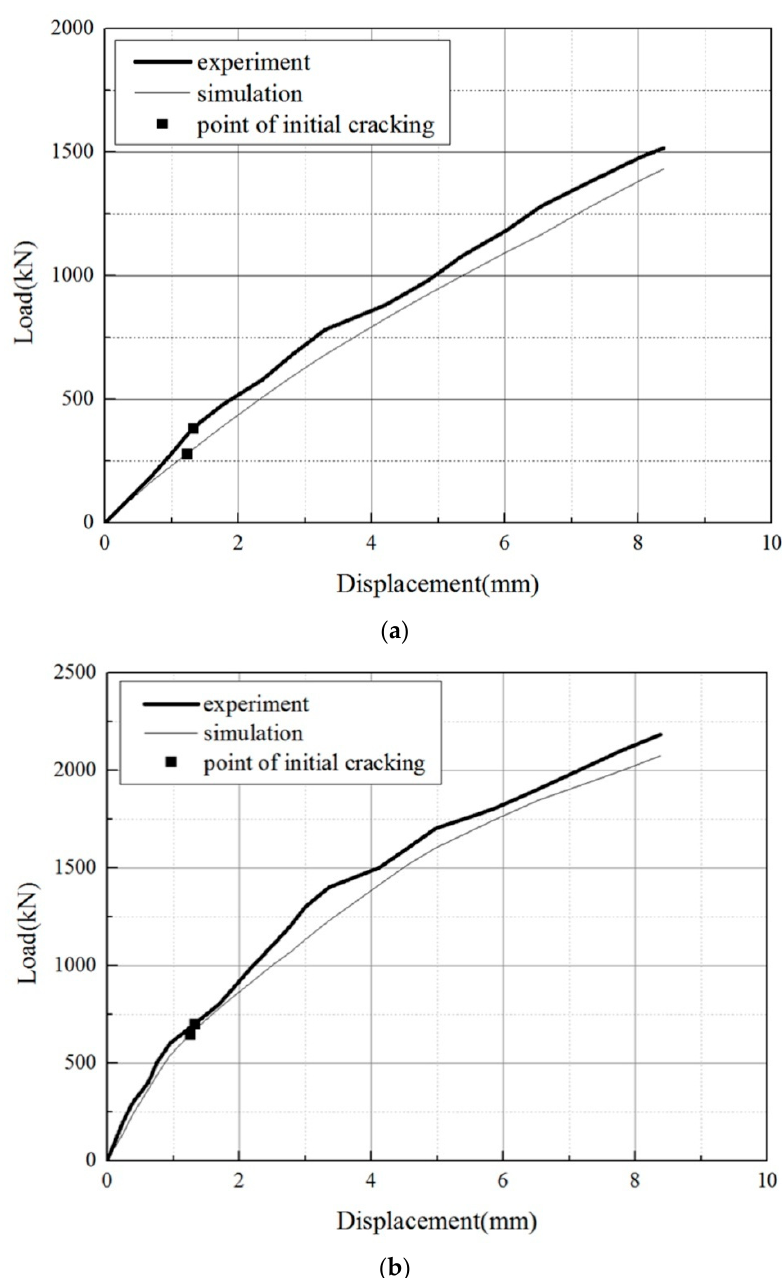
Figure 7. Load–displacement curves obtained from the experiment and finite element calculations: ( a ) specimen W1 and ( b ) specimen W2.